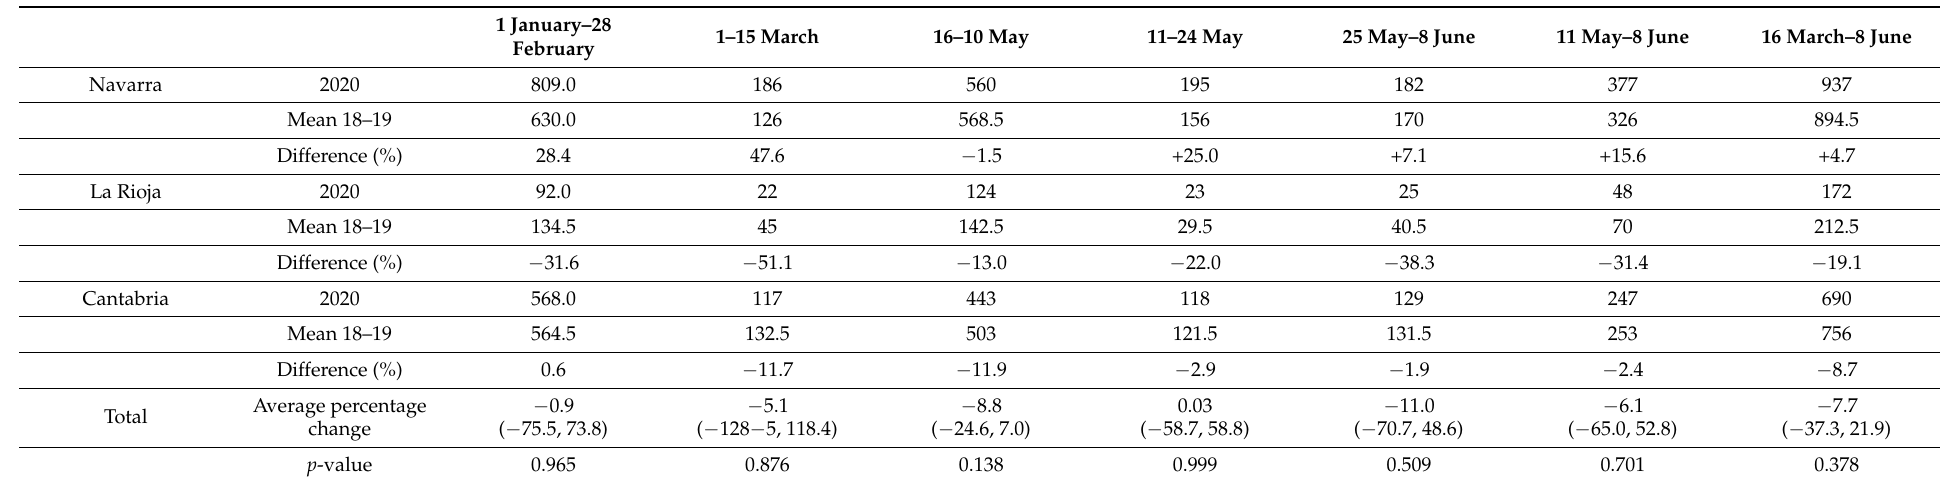
Table A2. Platelet distribution from transfusion centers.